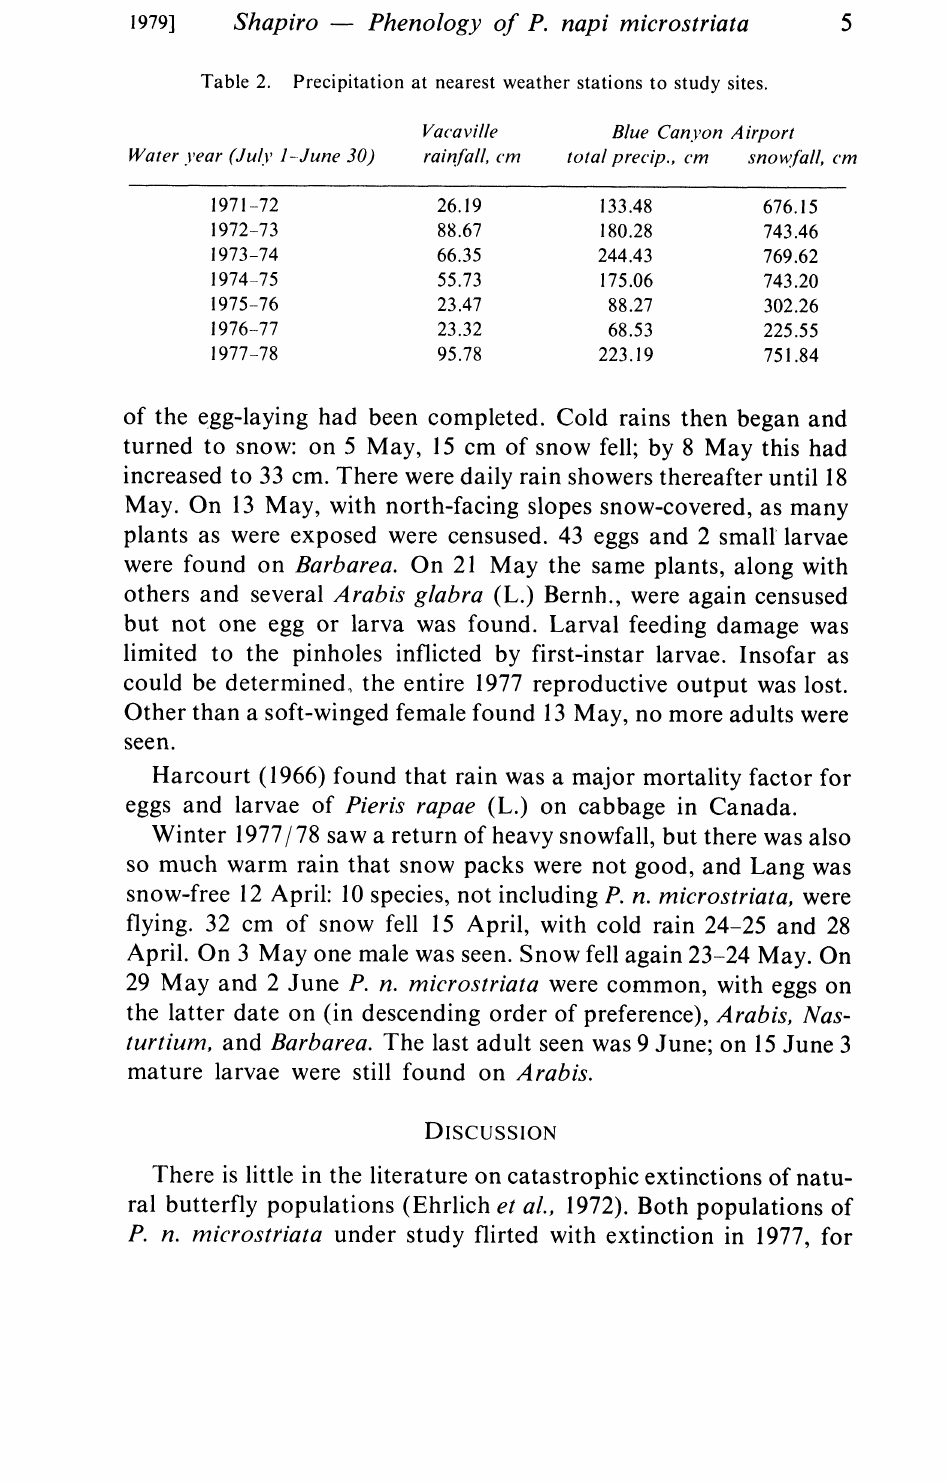
Table 2. Precipitation at nearest weather stations to study